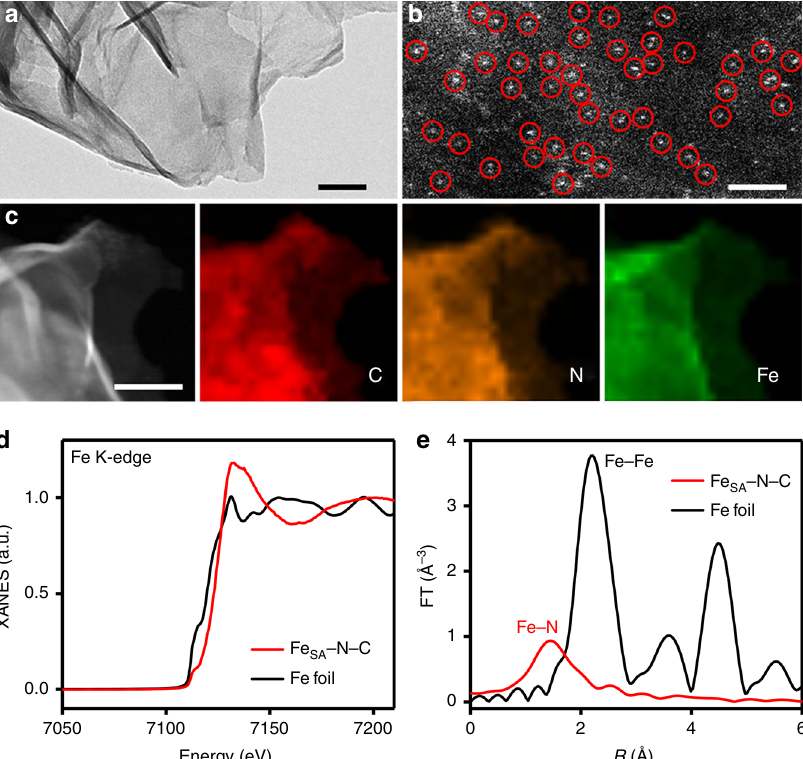
Fig. 1 Physical characterization. a Transmission electron microscopy (TEM) image of single-atom dispersed Fe – N – C (Fe SA – N – C). Scale bar, 50 nm. b High- angle annular dark- fi eld scanning transmission electron microscopy (HAADF-STEM) image of Fe SA – N – C. Single Fe atoms are highlighted by red circles. Scale bar, 2 nm. c High-resolution TEM (HRTEM) image and corresponding element maps showing the distribution of C (red), N (orange), and Fe (green). Scale bar, 50 nm. d X-ray absorption near-edge structure (XANES) spectra and e Fourier transform spectra at the Fe K-edge of Fe SA – N – C and Fe